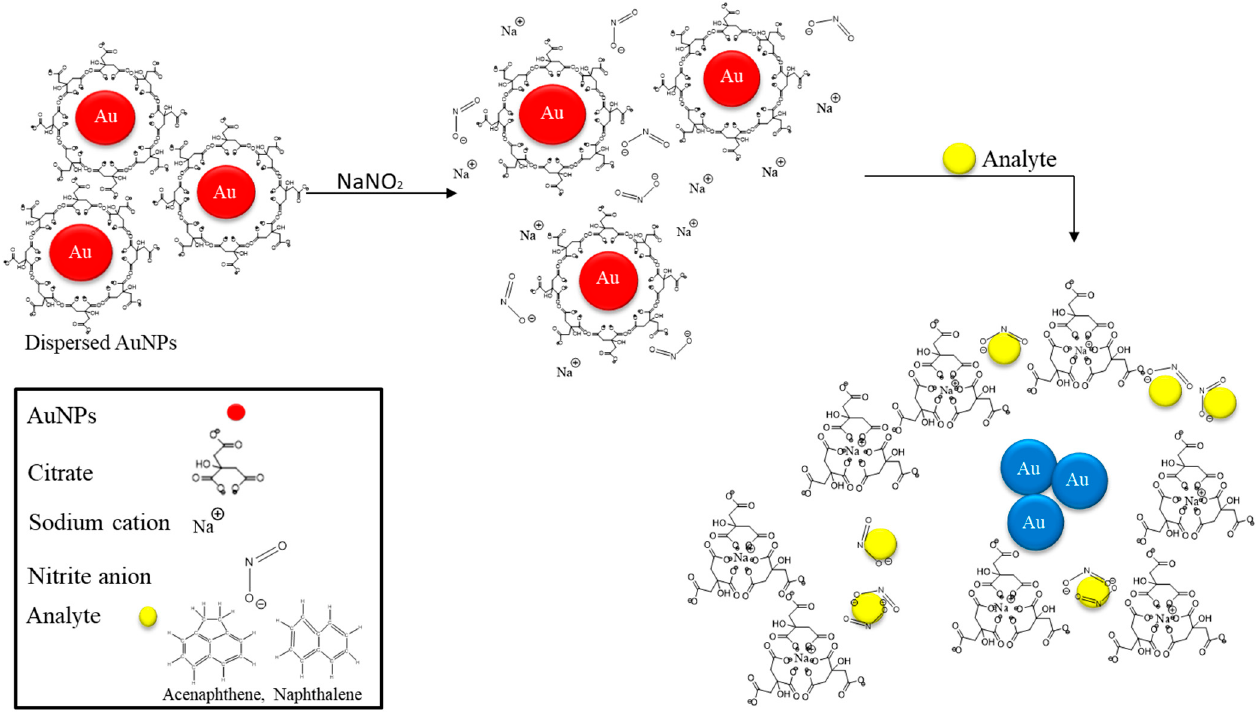
Figure 3 . Graphic sketch of Ace and Nap detection using functionalized AuNPs. Figure 3. Graphic sketch of Ace and Nap detection using functionalized